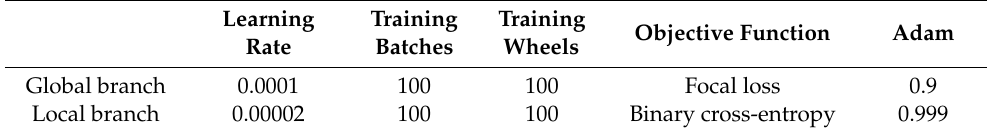
Table 2. The model super